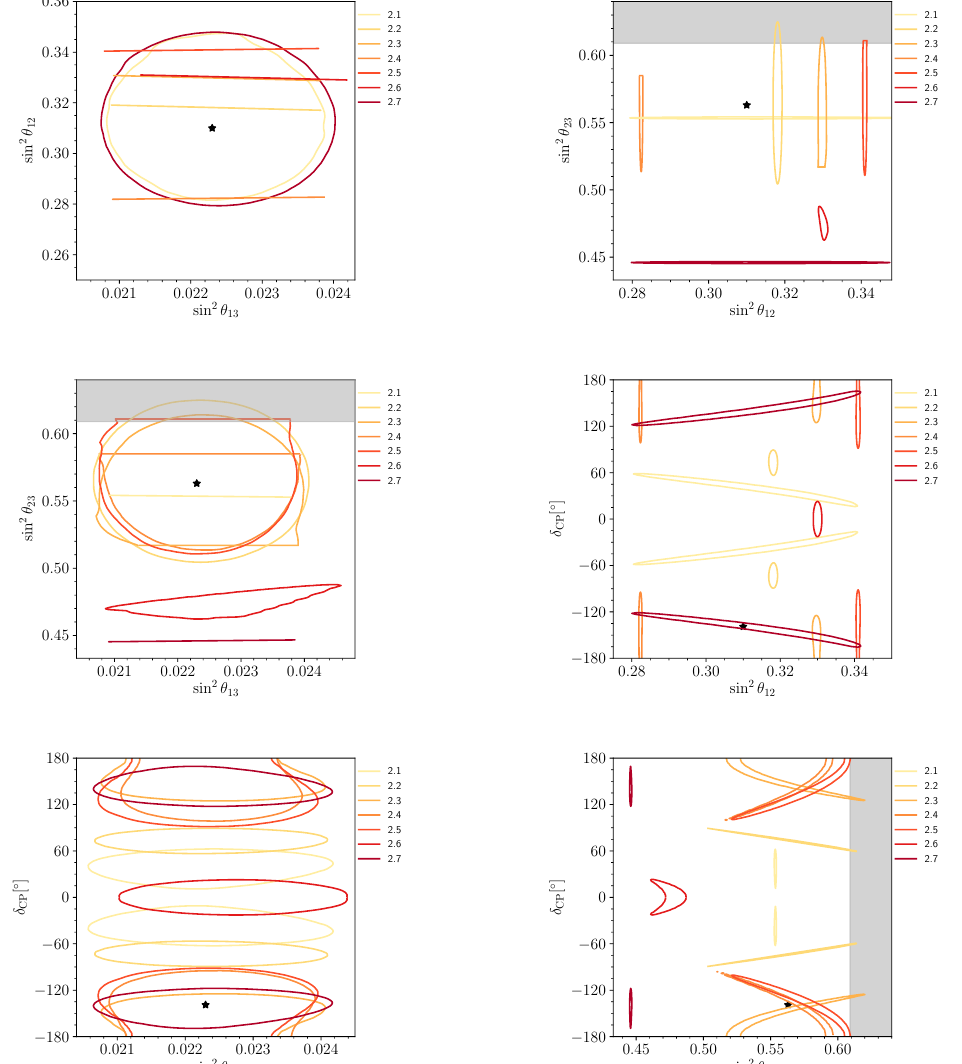
Figure 2 . Prediction of leptonic mixing parameters for the seven two-parameter models. The curves show the allowed contours of the leptonic mixing parameters for the 3 (cid:27) intervals (cid:18) 3 (cid:27) and (cid:30) 3 (cid:27) of the respective model parameters (cid:18) and (cid:30) given in table 8. The white areas show the allowed 3 (cid:27) regions of the leptonic mixing angles from (cid:12)ts to global neutrino oscillation data, whereas the gray- shaded areas show the corresponding excluded regions. A star (\ ? ") indicates the present best-(cid:12)t values of the leptonic mixing parameters from global neutrino oscillation data. Top-left panel: sin 2 (cid:18) 13 -sin 2 (cid:18) 12 . Top-right panel: sin 2 (cid:18) 12 -sin 2 (cid:18) 23 . Middle-left panel: sin 2 (cid:18) 13 -sin 2 (cid:18) 23 . Middle-right panel: sin 2 (cid:18) 12 - (cid:14) CP . Bottom-left panel: sin 2 (cid:18) 13 - (cid:14) CP . Bottom-right panel: sin 2 (cid:18) 23 - (cid:14) CP .